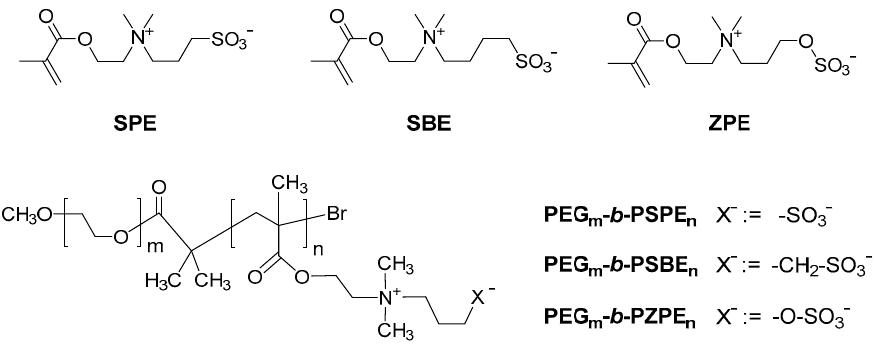
Figure 1. Structure of the zwitterionic monomers employed, and of the block copolymers synthesized and investigated. The number average degree of polymerization, DP n , of the PEG block was kept constant as m = 114. For the DP n values n of the various polyzwitterion blocks, see "Results and Discussion".